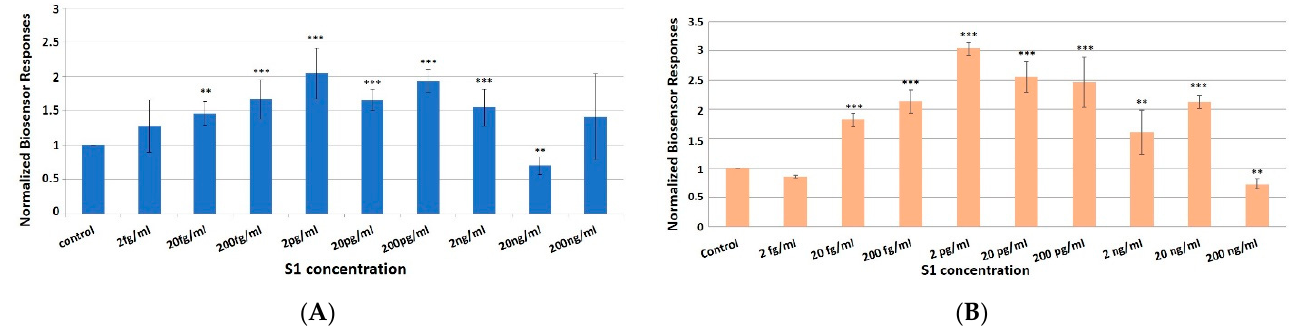
Figure 3. Normalized (ratio to control) cell biosensor’s responses in 3D cultures against the SARS ‐ CoV ‐ 2 spike S1 protein in PBS ( A ) and spiked nasopharyngeal solutions ( B ). SK ‐ N ‐ SH/ACE2 cells membrane ‐ engineered with 1500 Units/mL of ACE2 were used as the biorecognition elements. ***: statistically significant different results ( p < 0.001); **: statistically significant different results ( p < 0.01). Results (mean ± SD) are presented after 3 min (columns) of sample–cell interaction and are expressed as ratio to control ( n = 16).